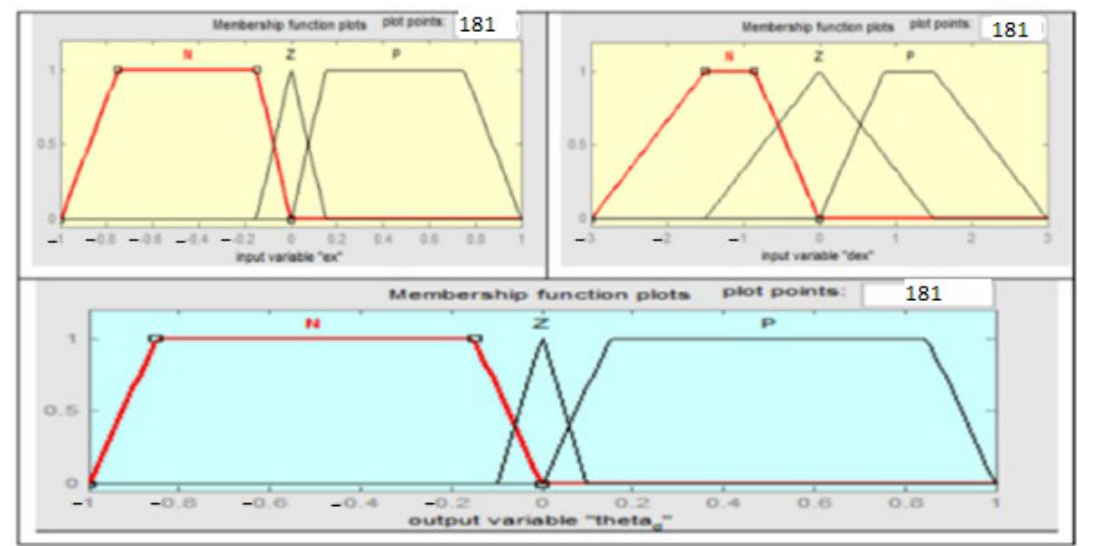
Figure 7. Error, Rate of Error, and Output Membership Functions. The surface view of all Fuzzy controllers is shown in Figures 8 and 9.